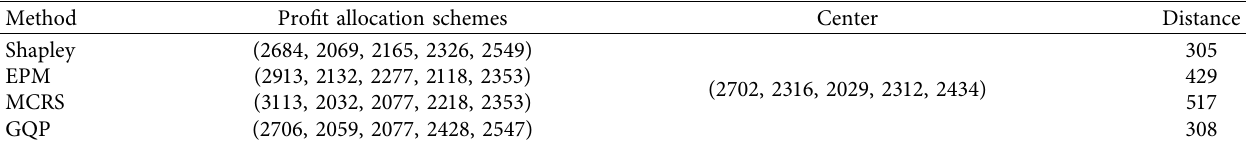
Table 12: Comparative results between different schemes and center value.